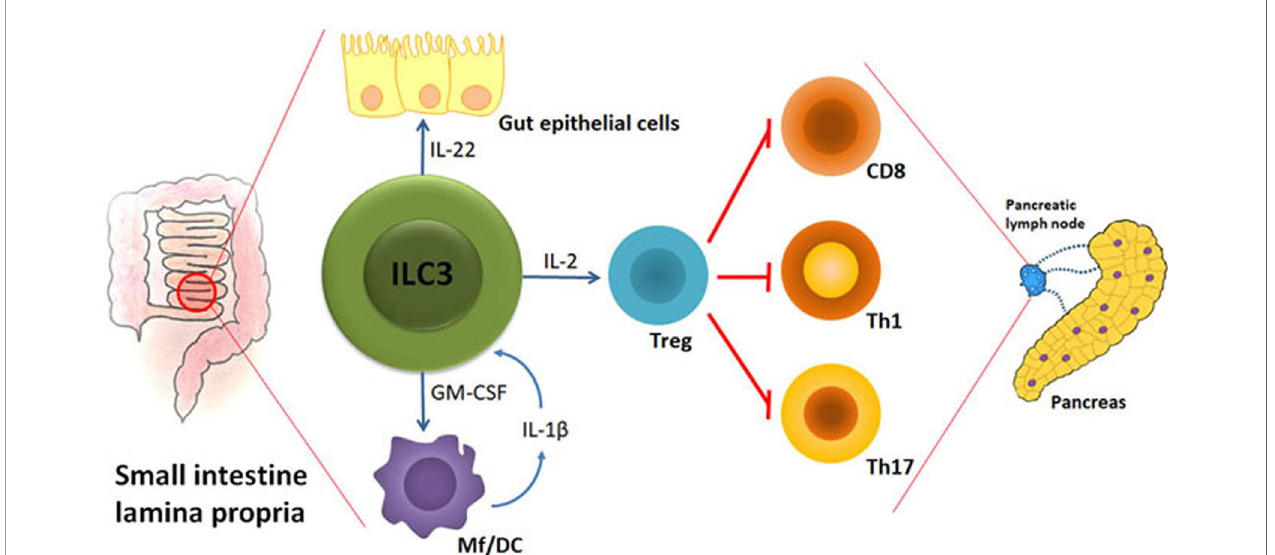
FIGURE 1 | The hypothetical model of ILC3-mediated effects on autoimmune process during T1D. Under the in fl uence of gut microbiota, their metabolites and food ingredients, intestinal ILC3 produce IL-22 that stabilizes the gut barrier and GM-CSF that in fl uences dendritic cells (DC) and macrophages (Mf). Upon activation by microbial cues, Mf produce IL-1 b that stimulates ILC3 to increase their production of IL-2 and thus promote intestinal Treg stability and proliferation. Intestinal Treg are able to migrate to the pancreatic lymph nodes and modulate the autoimmune response by providing a suppressive environment in which cytotoxic CD8 + cells, Th1 and Th17 cells are inhibited. The fi nal outcome is the blockade of T cell-mediated autoimmune destruction of pancreatic b